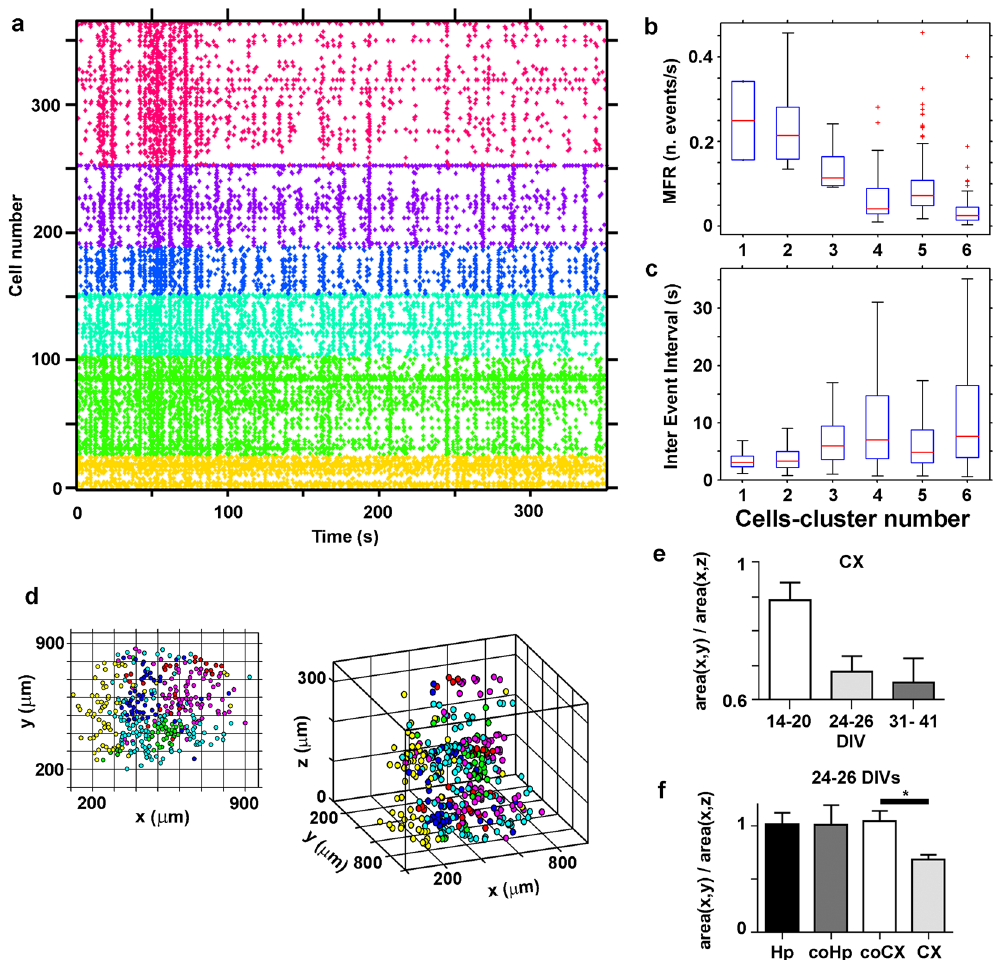
Figure 6. Clustering of spike pattern activities. ( a ) Raster plot of a 3D cortical network at 26 DIVs, with cells ranked according to the functional clustering. Cells are divided into 6 classes according to their activity profiles over time; ( b ) Comparison of the distribution of the Mean Firing Rate (MFR) among the 6 detected clusters of the network of panel a); ( c ) Comparison of the distribution of the Inter Events Intervals (IEIs) among the 6 detected clusters of the network of panel a). Boxplots in ( b and c ) show the median and the interquartile range. Outliers are considered all those values whose distance from the first (or third) quartile is larger than 1.5 times the interquartile range. The results in ( b and c ) show that the calcium activity is significantly different between each pair of the identified clusters (Mann-Whitney U-test, p < 0.05, two-tailed); ( d ) Spatial distribution of the cell somata colored according to the clustering (x-y view on the left, x-y-z view on the right) of the network of panel a. The x-y view suggests that clusters are spatially localized. The 3D view, instead, suggests that they are well distributed along the third dimension; ( e ) Quantification of the ratio of average area covered by each cluster (divided by the number of cells belonging to the cluster) in the transversal view and in the coronal- sagittal view of 3D cortical cultures (indicated as CX in the figure panel). The covered area differs significantly between the two views at DIVs > 14 (Mann-Whitney U-test, n = 13, 14, 9 total number of clusters identified in three distinct experiments of the groups of 14–20 DIVs, 24–26 DIVs and 31–41 DIVs respectively, p = 0.7869, p = 0.0085 and p = 0.0117 respectively, two-tailed) for cortical neuronal networks in panel e). Data are shown as mean + standard errors. ( f ) The same quantification reported in panel e), for single hippocampal (Hp) cortical (CX) culture, and cortical (coCX) or hippocampal networks (coHp) analyzed in layered co-cultures at 24–26 DIVs. (Mann-Whitney U-test, n = 13, 8, 9, 14 total number of clusters identified in three distinct experiments of the groups Hp, coHp, coCX and CX respectively, p = 0.0317,